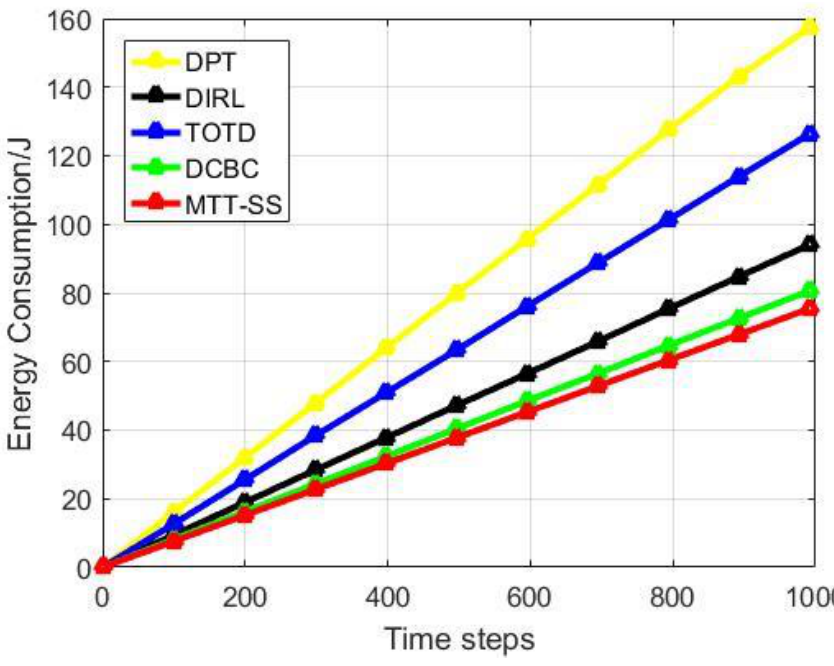
Figure 8. Energy consumption.